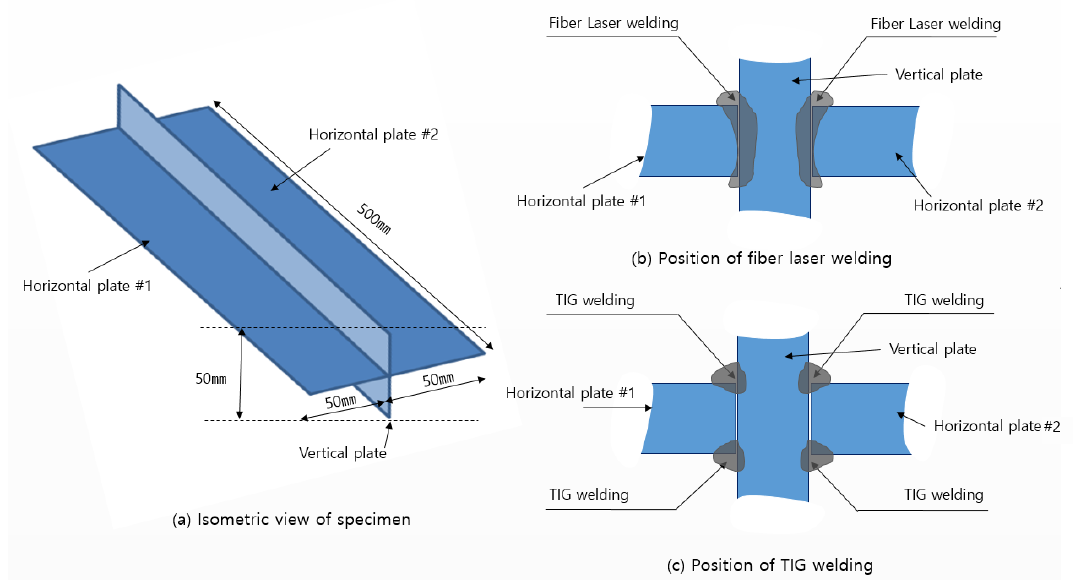
Figure 1. Experimental schematic diagram and welding location. ( a ) Isometric view of specimen ( b ) Position of fiber laser welding ( c ) Position of TIG